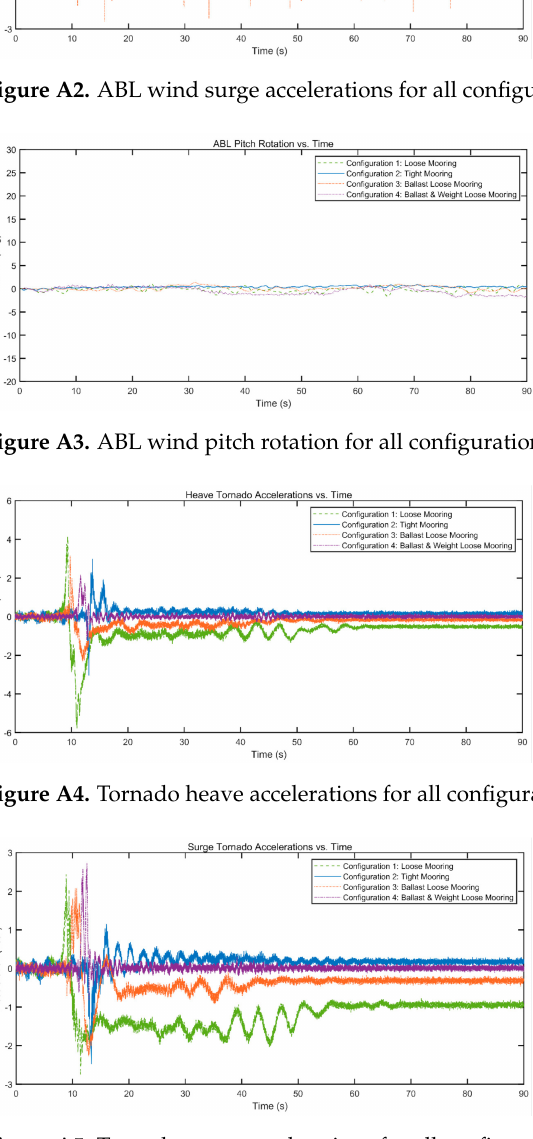
Figure A5. Tornado surge accelerations for all